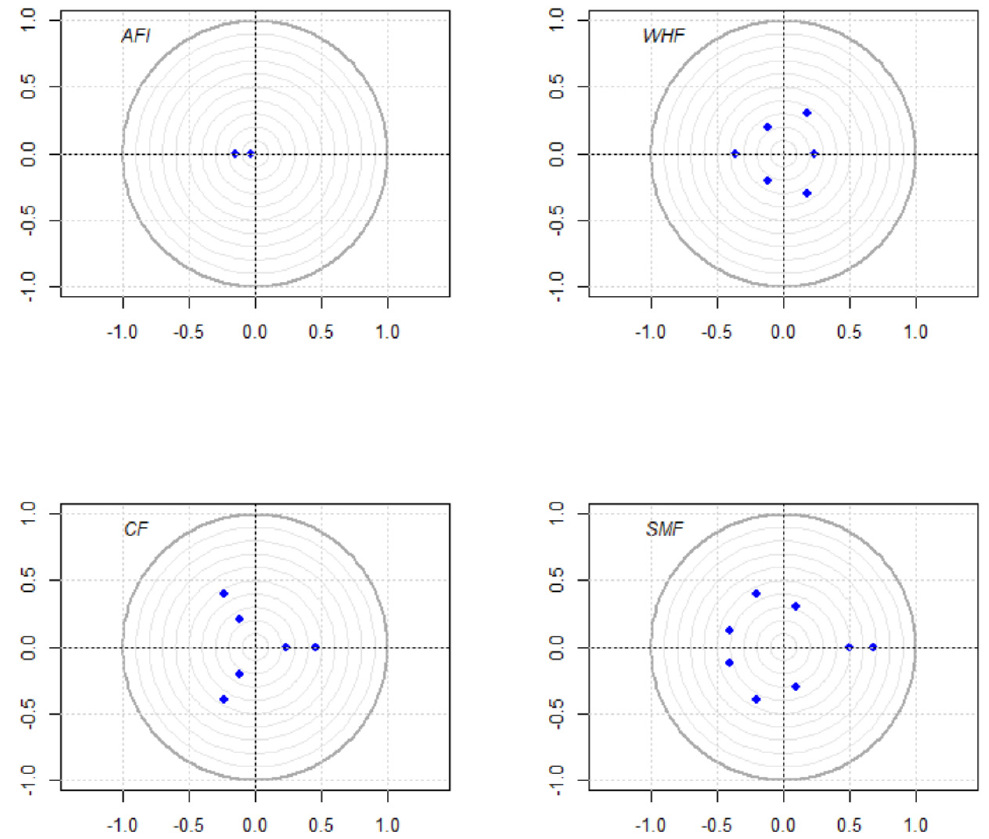
Figure 1. Stability test for VAR models.